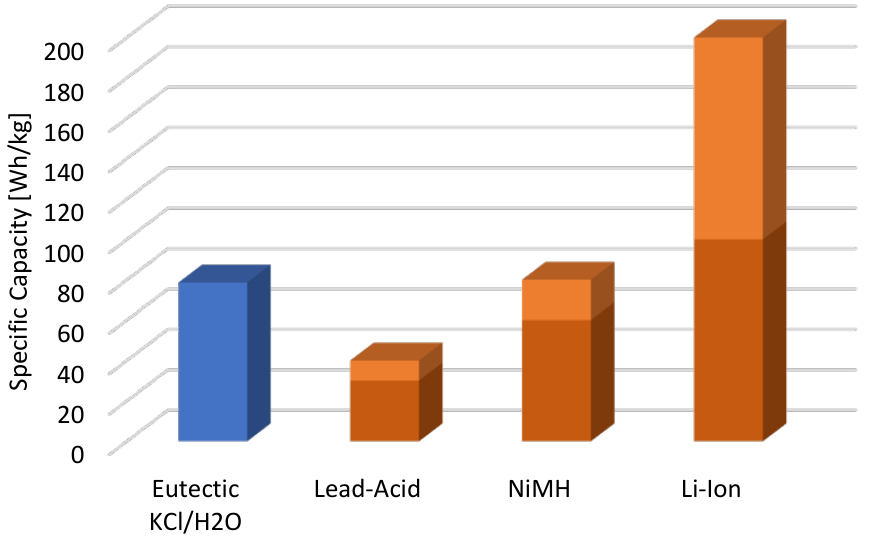
Figure 7. Comparison of the specific capacity of a eutectic KCl+H2O PCM with the three more common types of electrolytic batteries [57,59].